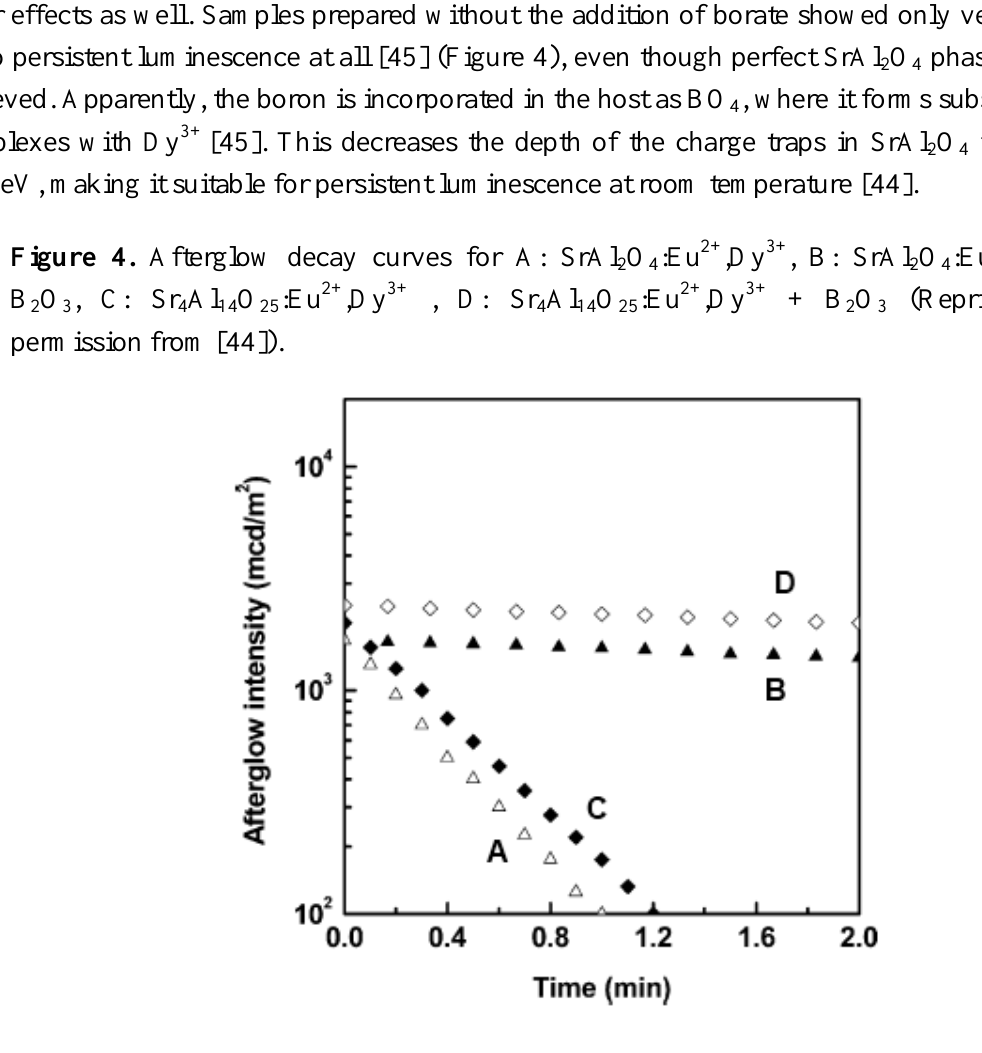
O :Eu 2+ ,Dy 3+ , B: SrAl 2 4 Al O :Eu 2+ ,Dy 3+ + B 4 14 25